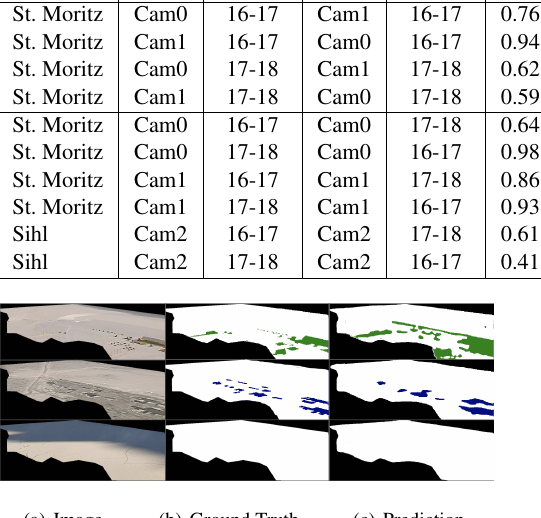
against cloud/mountain shadows cast on the lake (row 3). In human labeling errors, where humans are present on the frozen lake, but not annotated due to their small size.